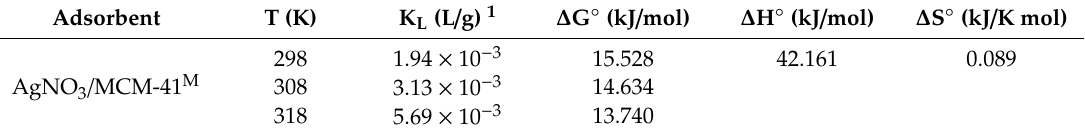
Table 5. Thermodynamic parameters for sulfur adsorption on AgNO 3 /MCM-41 M . Experimental conditions: room pressure, real diesel with sulfur concentration ranging from 25 to 500 ppm.